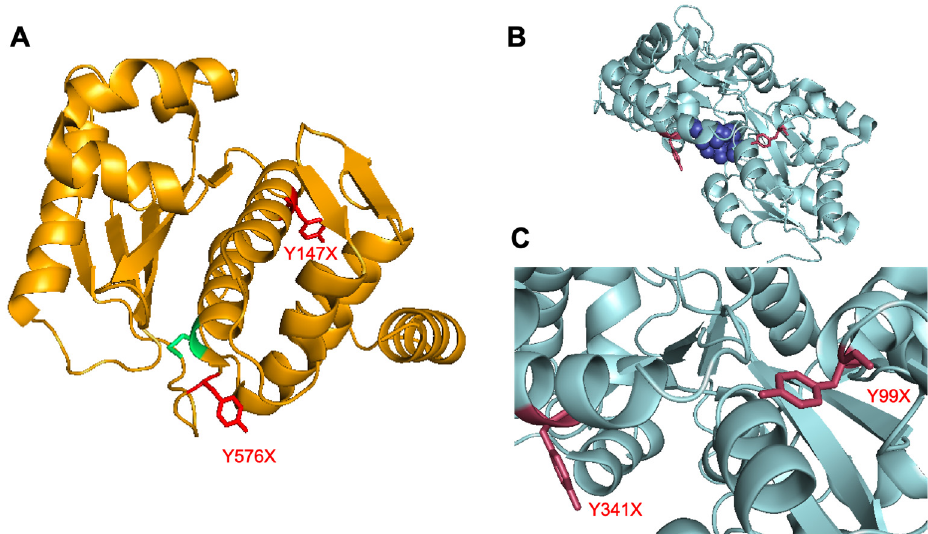
Figure 2. Crystal structures with surface-exposed tyrosine residues for ncAA incorporation. ( A ) Crystal structure of S. cerevisiae ULP1 protein. UTAG protein is generated via mutation of catalytically active cys residue (green). Sites of surface exposed tyr residues (red) were identified as ideal locations for ncAA incorporation (PDB 2HKP) [27]. ( B ) Crystal structure of maltose-binding protein (MBP) that is expressed as a fusion with UTAG (PDB 3RLF) [28]. The active site is displayed with an amylose bound (dark blue). ( C ) Closer image of the two tyr residues (red) selected for ncAA incorporation. The first Y99 is in a loop structure with significant conformational freedom, and the Y341 is projected outward from an α